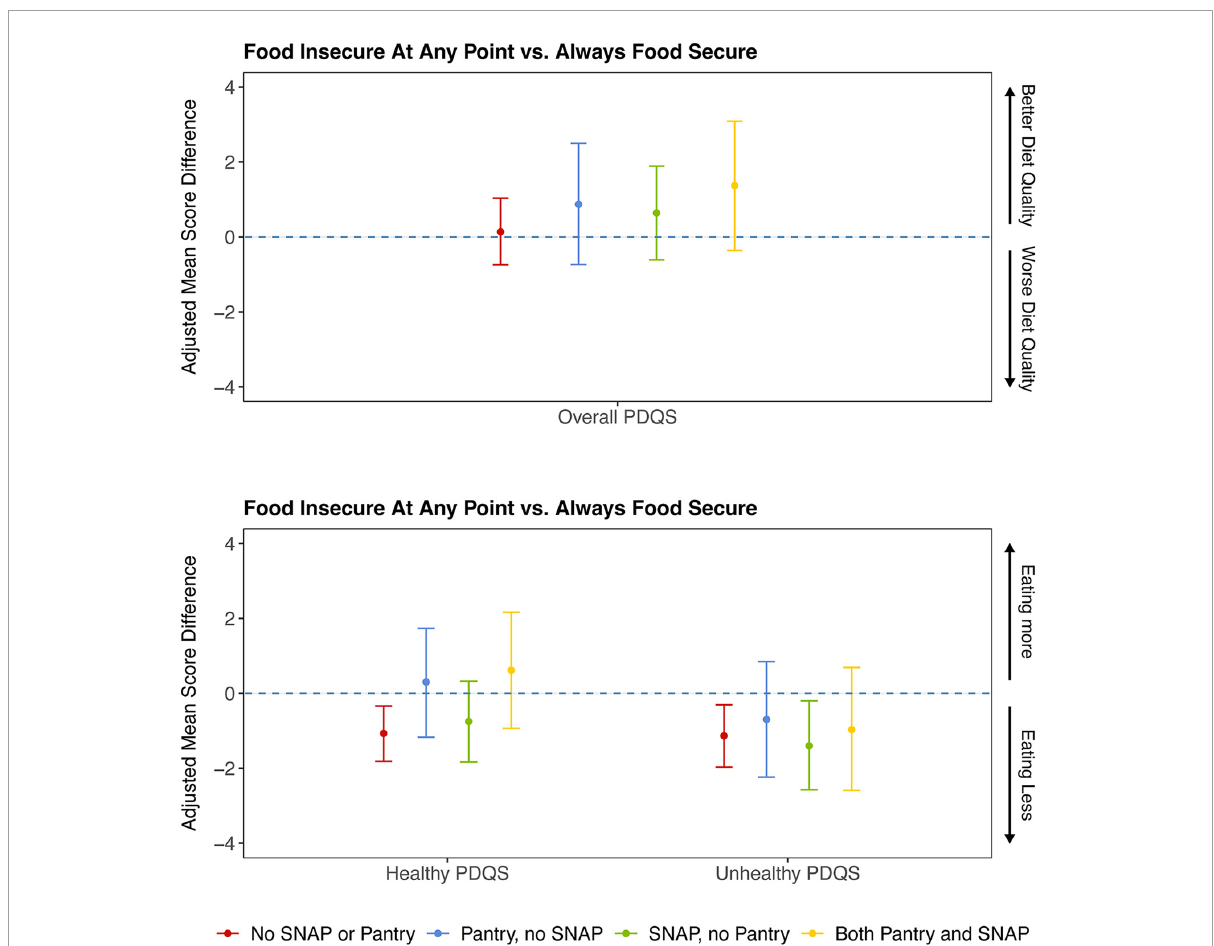
FIGURE2 Prime Diet Quality Score 1 , adjusted mean differences 2 , by program participation and food insecurity status. 1 Three types of Prime Diet Quality Scores were assessed as outcomes: overall, healthy, and unhealthy. For the overall scale (out of 70), higher scores indicate higher frequencies of healthy items and lower frequencies of unhealthy items. For the healthy scale (out of 30), higher scores indicate higher frequencies of healthy items. For the unhealthy scale (out of 40), higher scores indicate higher frequencies of unhealthy items. A point estimate that does not include the null value (0) indicates a significant adjusted mean difference in diet quality score comparing those who are food insecure to those who were always experiencing food security for a specific stratum of program participation. For example, the first red line under the “Healthy PDQS” collection of estimates indicates that individuals who were food insecure at any point consumed less healthy items than those who were experiencing food security at all time points on average, among those who did not participate in SNAP or in food pantries within the last month, adjusted for covariates. 2 Mean differences shown are adjusted for gender, age, race/ethnicity, highest educational attainment, household size, presence of children in the household, current employment status, experience of job disruption, income as a% of the federal poverty level, month the survey was taken, WIC or school meals participation in the past month, self-rated poor or fair health, poor mental wellbeing, and neighborhood median income, proportion below 185% FPL, and proportion without a high school diploma. Models were weighted by MA Statewide Food Access survey weights. PDQS, Prime Diet Quality Score; SNAP, Supplemental Nutrition Assistance